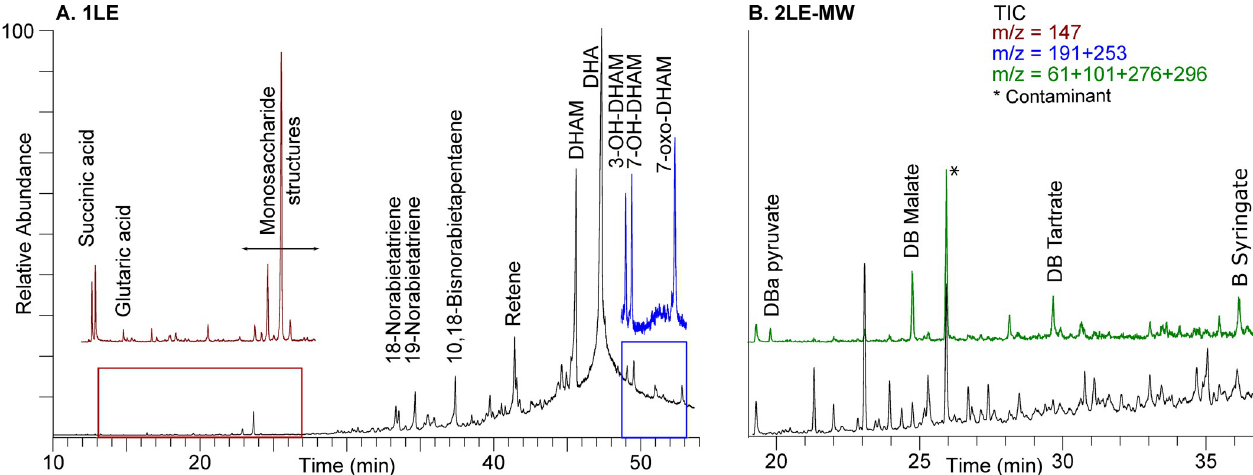
Fig 2. GC-MS chromatogram for the pitch of SFC1. A. represents the first extraction (1LE) and B. corresponds to 2LE-MW, the butylated second extraction. Total Ion Current (TIC) is black-colored. Red, blue and green colors refer to fragment ions searching (respectively m/z 147 (succinic and glutaric acids) and m/ z 191; 253 (hydroxy- and oxo-abietanes) in 1LE and m/z 61; 101; 276; 296 (dibutylacetal pyruvate; dibutyl malate; dibutyl tartrate; butyl syringate in 2LE-MW).